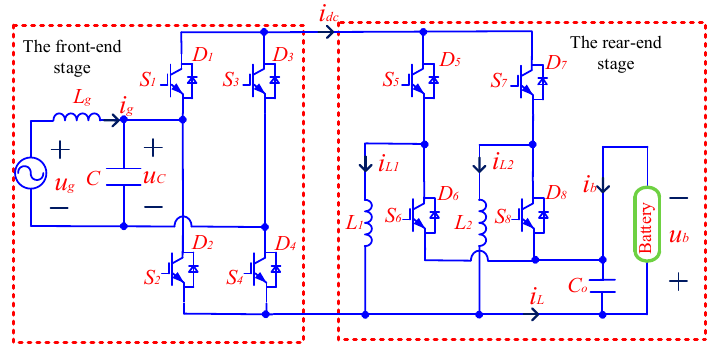
Figure 1. The presented bidirectional converter topology.